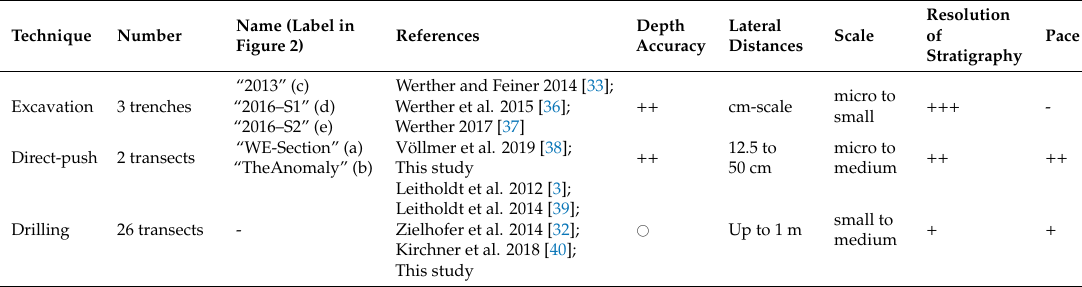
Table 1. Depth accuracy, scale and stratigraphical resolution of trench geometry data; scale classification according to Zielhofer et al.